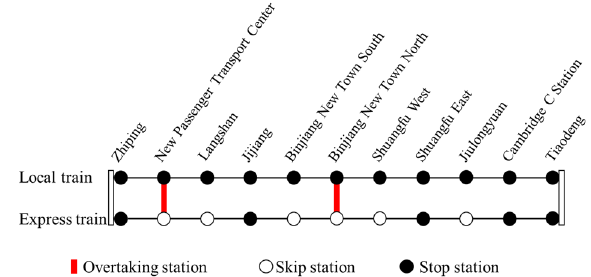
Figure 8. Optimal E/L mode for the Jiangjin Line.